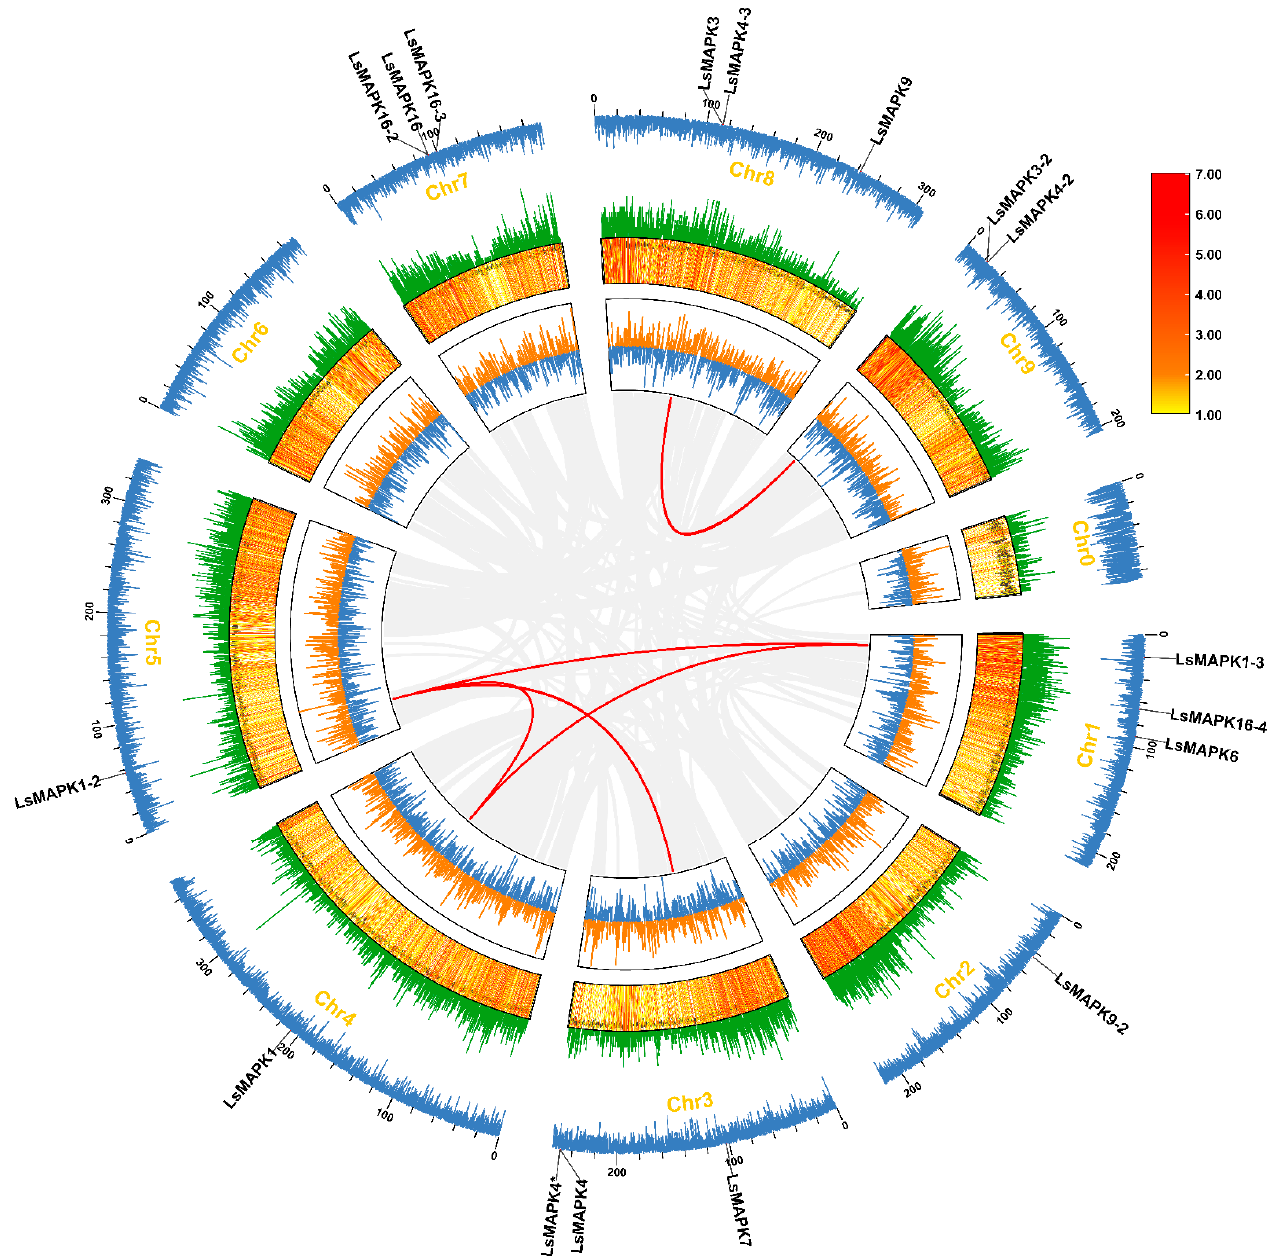
Figure 5. Collinearity analysis of the LsMAPK gene family. The gray line in the background represents the homolinear pair in the whole lettuce genome, and the red line represents the homolinear pair of LsMAPKs . The information represented by each circle in the figure is GC skew, genome density heatmap, GC radio, genome density linear map, chromosome name, N radio, chromosome length scale, and LsMAPKs chromosome location annotation from inside to outside.